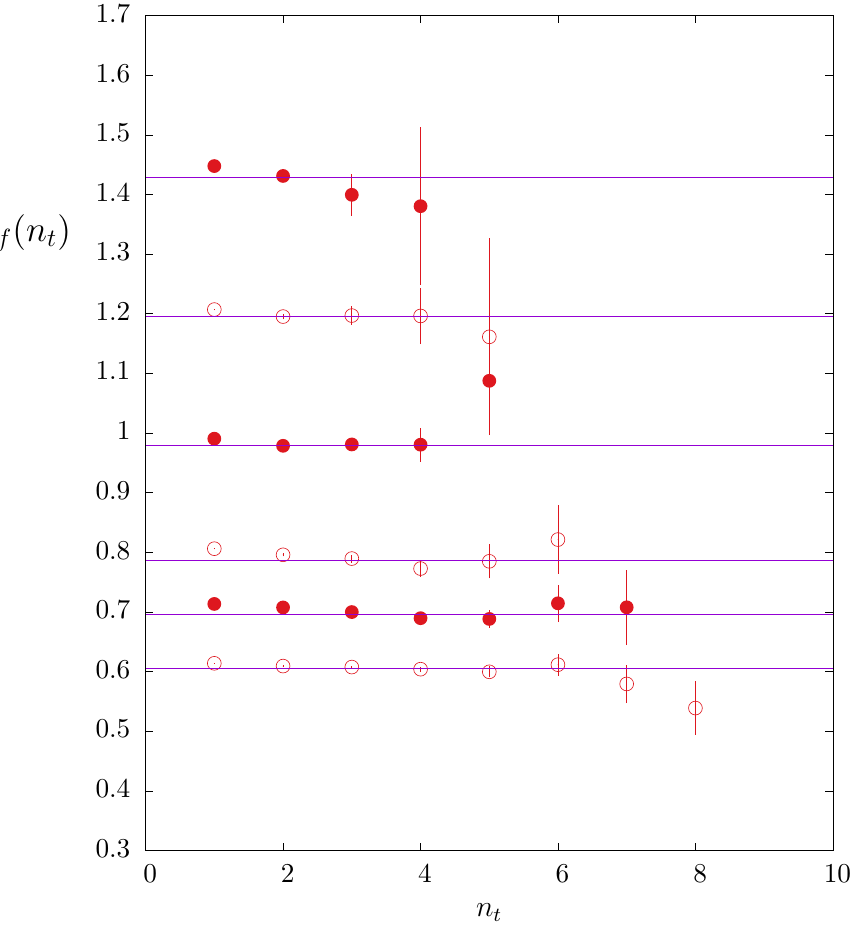
p (cid:27) (cid:24) 6 : 0,